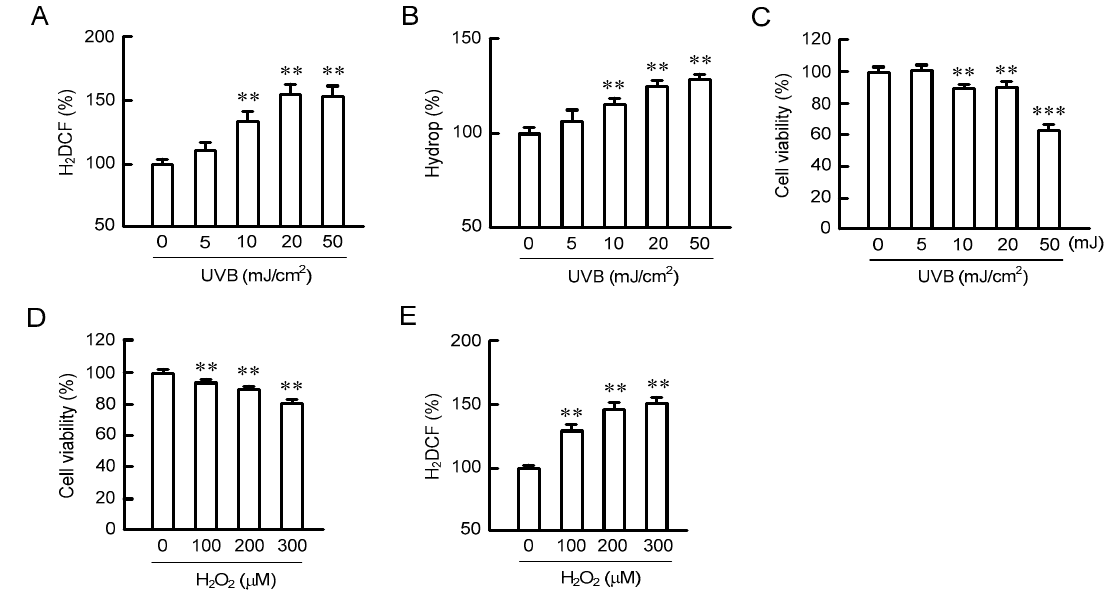
Figure 1. Effects of UVB and H 2 O 2 on reactive oxygen species (ROS) production and cell toxicity in HaCaT cells. ( A,B ) Cells exposed to UVB were cultured for 3 h and then incubated with 2’,7’-dichlorodihydrofluorescein diacetate (H 2 DCFDA) (ROS) and Hydrop (H 2 O 2 ) for 30 min. The florescence intensities of each dye were measured using an Infinite F200 Pro microplate reader and are shown relative to the values (0 mJ/cm 2 ). ( C,D ) Cells were exposed to UVB or transiently exposed to H 2 O 2 for 3 h, and then they were cultured for 24 h. Cell viability was measured using a WST-1 assay. ( E ) Cells were exposed to H 2 O 2 for 3 h, and then they were incubated with H 2 DCFDA. The florescence intensities of H 2 DCF are shown as relative to the values in 0 μ M H 2 O 2 . n = 4–6; *** p < 0.001 and ** p < 0.01 significantly different from 0 mJ/cm 2 UVB or 0 μ M H 2 O 2 .